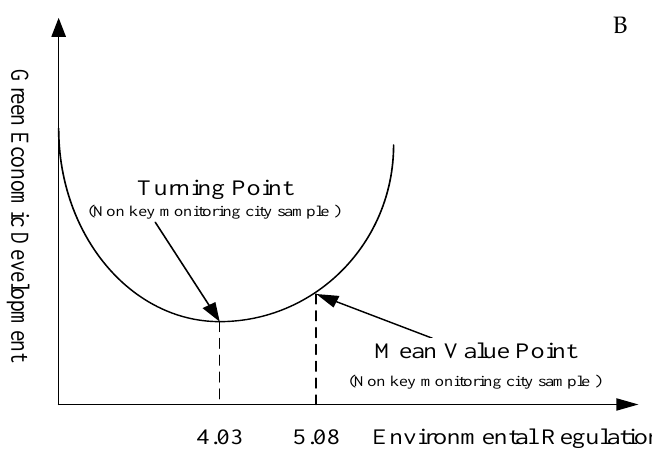
Figure 4. Nonlinear relationship between ER and GTFP. ( A ) Key monitoring cities; ( B ) non-key monitoring cities.